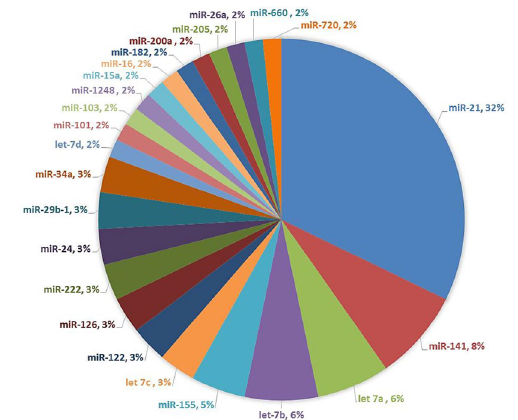
Fig. 4. The frequency of miRNAs reported as the target in reported miRNA-nanobiosensors. Data collected from Web of Science